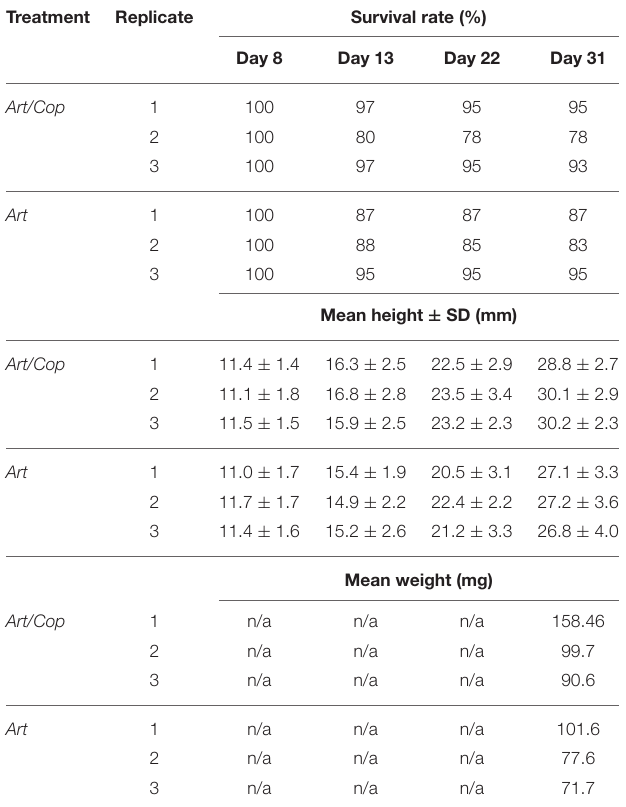
TABLE 1 | Survival rates, mean heights, and mean weights of Hippocampus reidi specimens of treatments Art/Cop (replicates 1–3) and